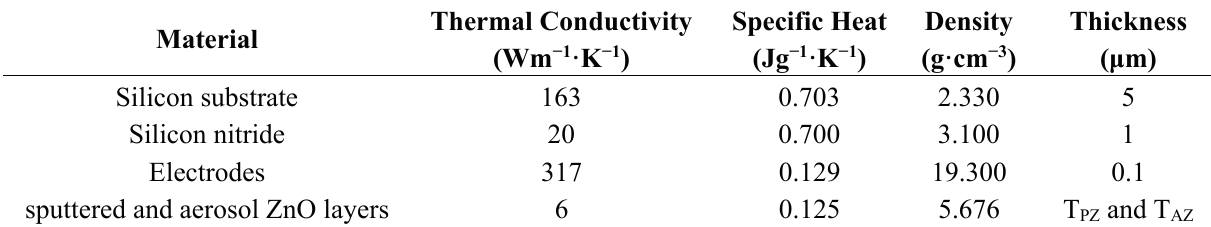
Table 4. Material parameters used for the